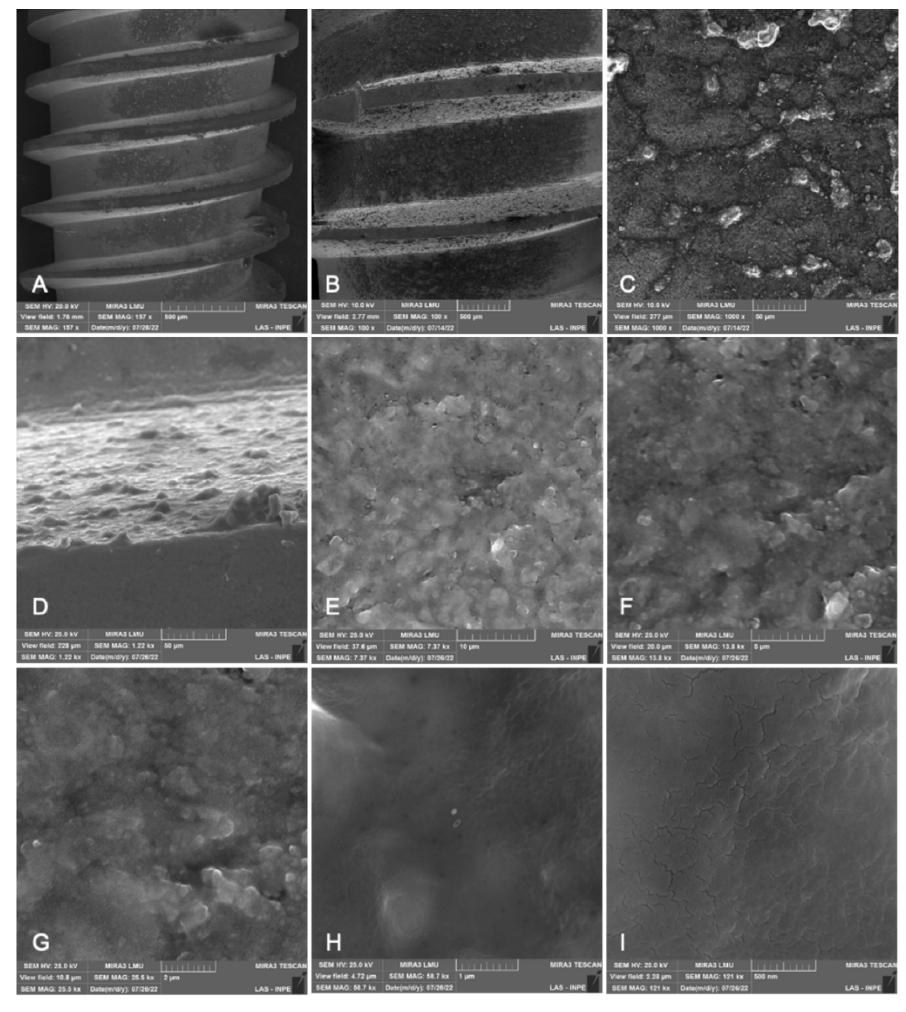
Figure 3. Micrographs of representative samples of titanium implants. SEM images of the surface at different magnifications: ( A ) 57×; ( B ) 100×; ( C ) 1000×; ( D ) 1220×; ( E ) 7370×; ( F ) 13,800×; ( G ) 25,500×; ( H ) 58,700×; ( I ) 121,000×.